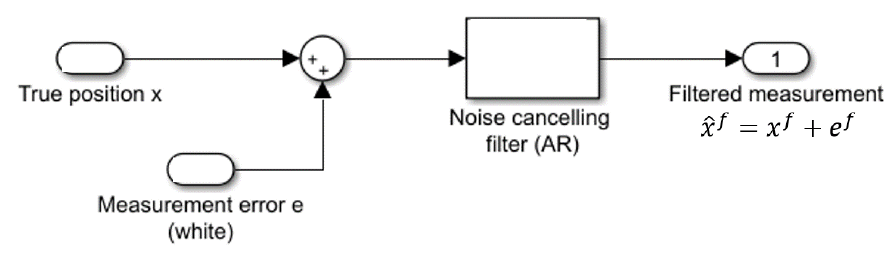
Figure 10. Assumed noise filtering of position